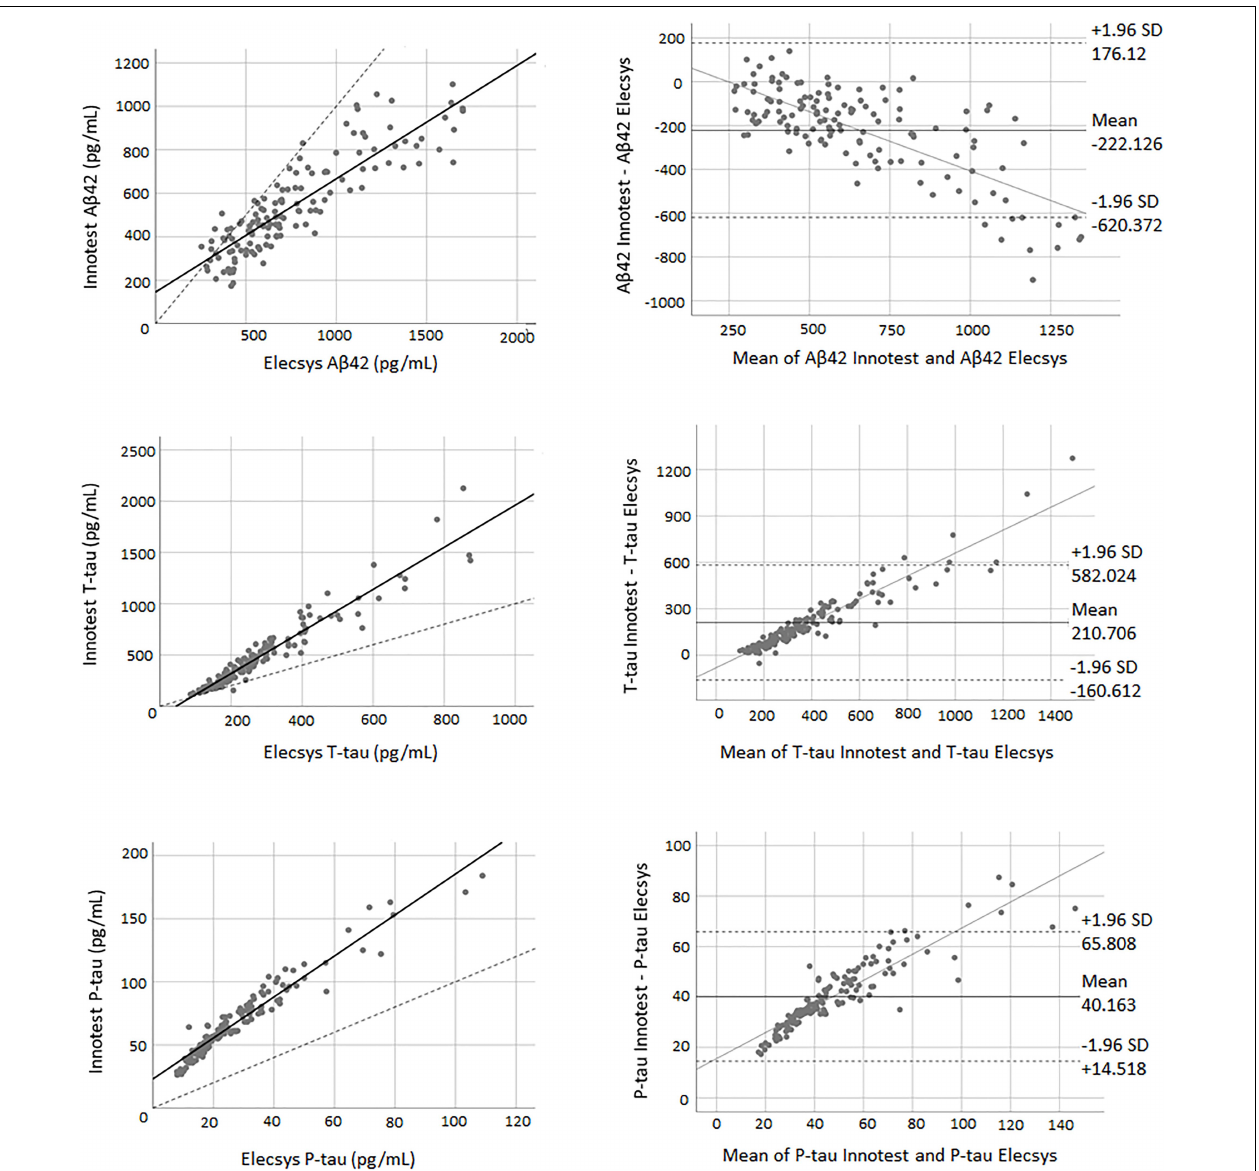
FIGURE 2 | The correlation and Bland-Altman plots for A β 42, T-tau, and P-tau measurements obtained by Elecsys and Innotest methods (for P-tau and T-tau n = 145; for A β 42 n = 135). Each point is defined as the measurement of Elecsys and Innotest assays on the same biological sample. In correlation plots, the solid lines represent the estimated regression line, and the dotted line represents the identity line ( x = y ). In the Bland-Altman plots, solid lines represent the slope